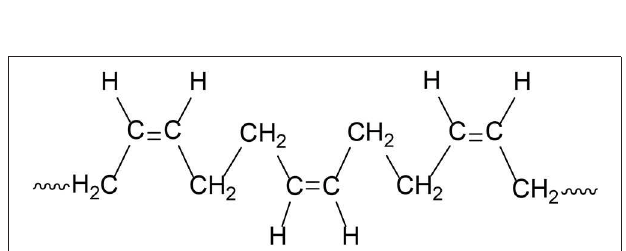
FIGURE 8 | Cis - 1,4-polybutadiene.